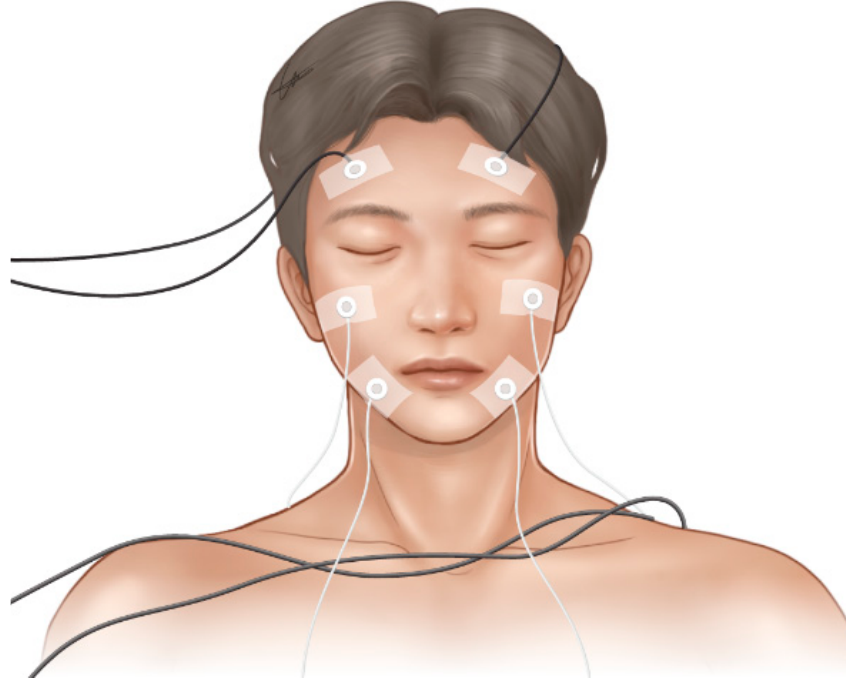
Figure 3. Measurement of facial temperature in six regions (right forehead area, left forehead area, right maxillary area, left maxillary area, right mandibular area, left mandibular area) by a skin ther- mometer.